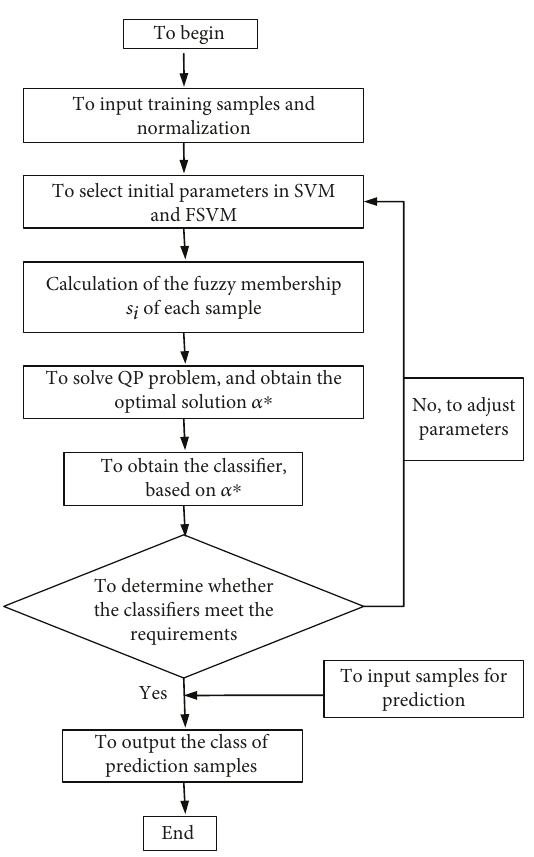
Figure 2: Flow chart of FSVM and SVM